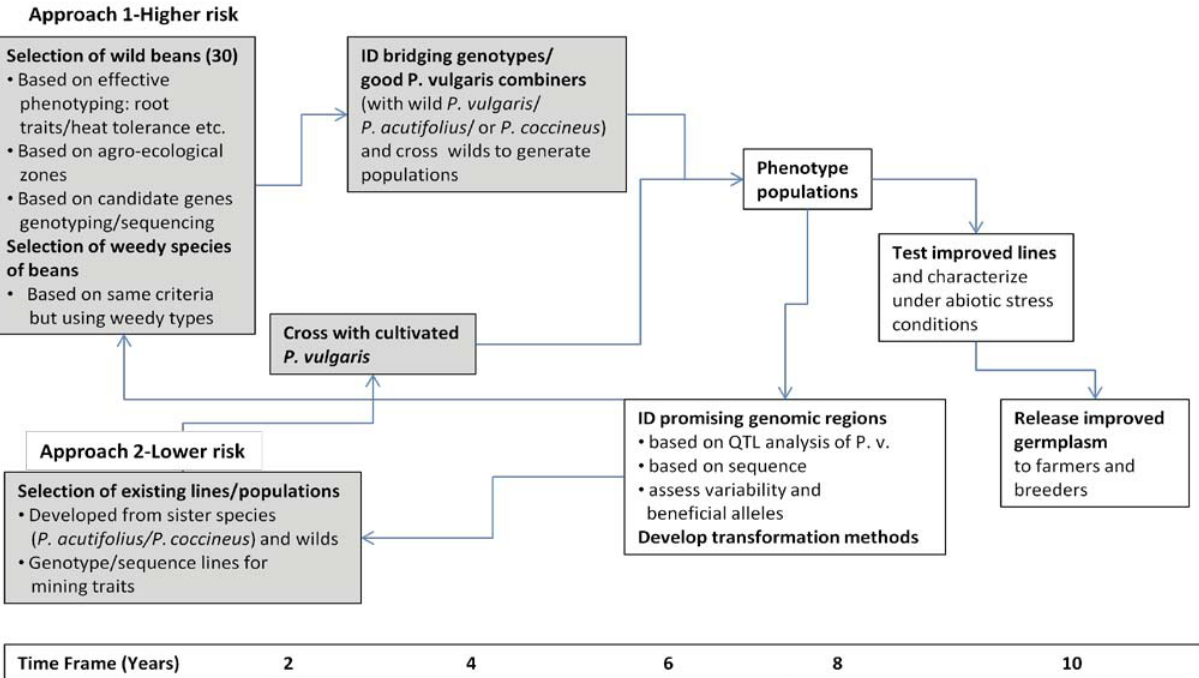
Figure 3. Approaches for introgression of exotic heat and drought-related traits from wild relatives of common